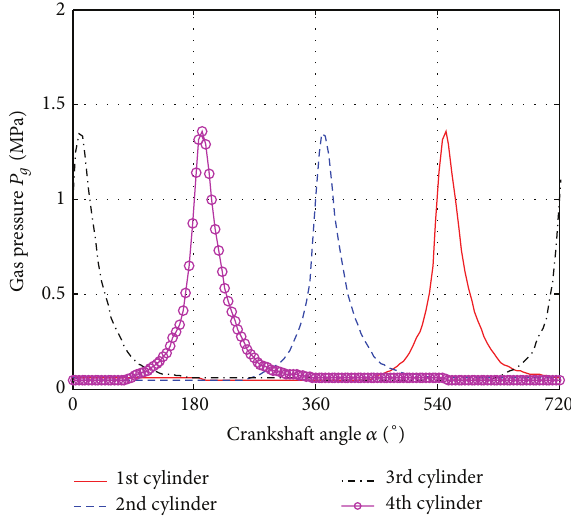
Figure 5: Each cylinder’s gas pressures of the engine.